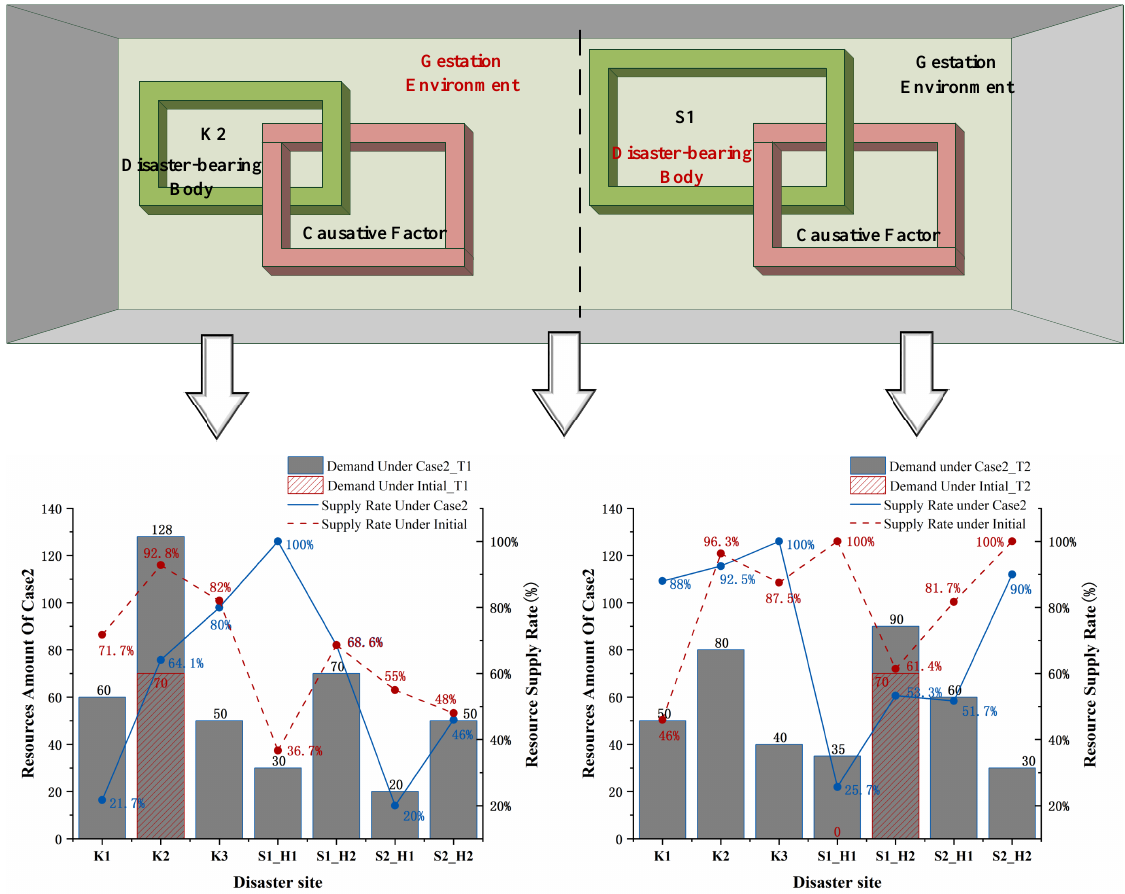
Figure 9. Allocation of emergency resource under the initial scenario and the